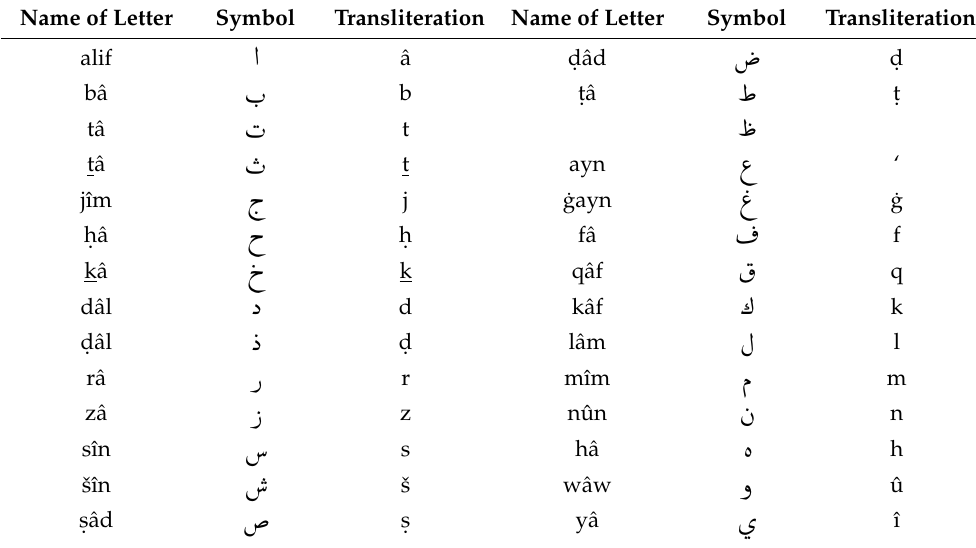
Table 6. Code between Latin characters and Arabic and Berber